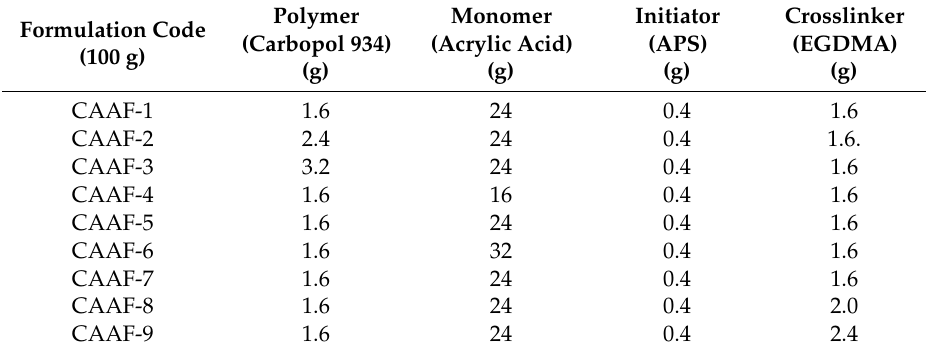
Table 2. Feed ratio scheme for the formulation of Car934-g-poly (acrylic acid) hydrogels. Formulation